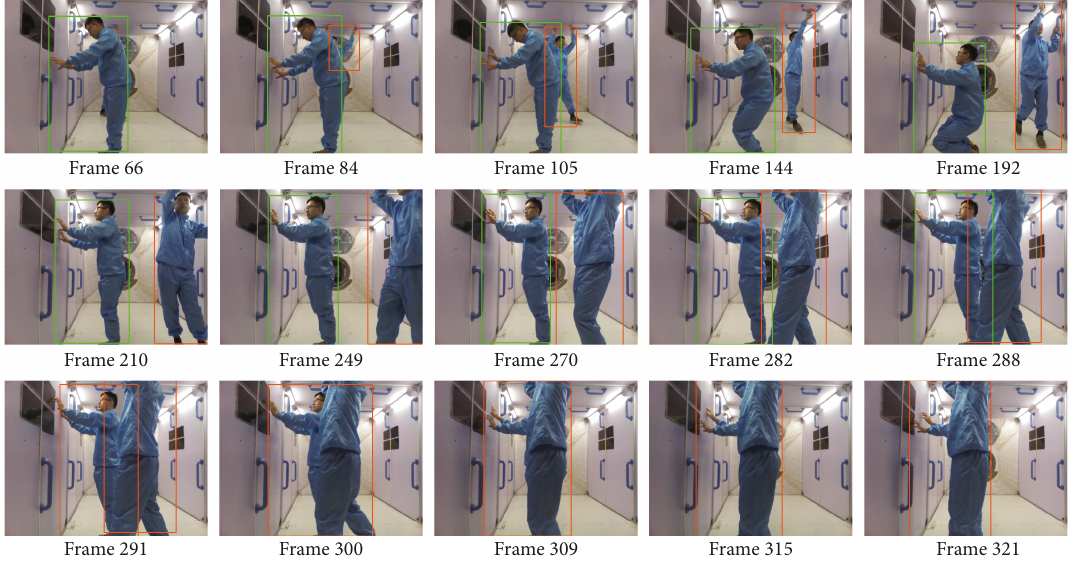
Figure 18: Occlusion detection for avoiding mistaken